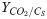
MDF and CO2 assimilation yield YCO2/CS of EMs for selected substrate-product combinations.EMs with the same color share the same MDF. The black solid line indicates the optimal MDF for a given CO2 assimilation yield.